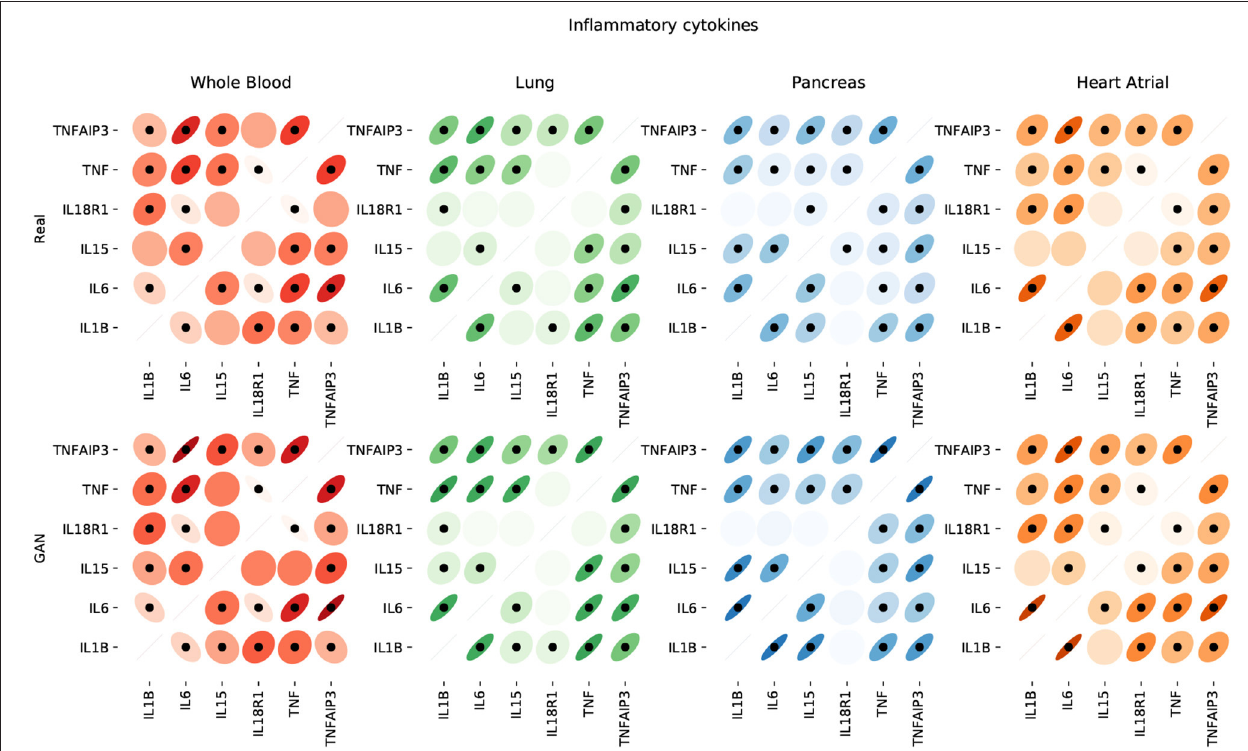
FIGURE 11 | Pairwise correlations between inflammatory cytokines in the 4 modeled tissue types. We use dots to label statistically significant correlations (two-sided p -value < 0.05).